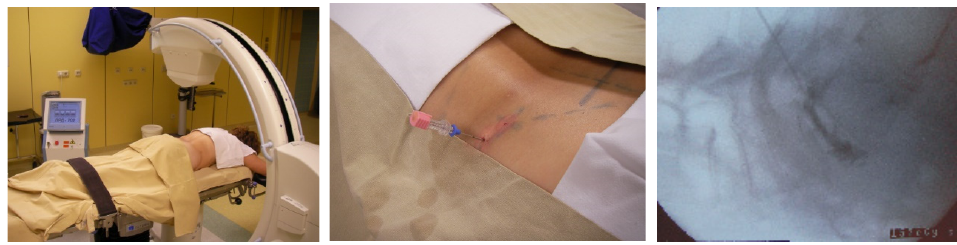
Figure 7. LRD of the lumbar